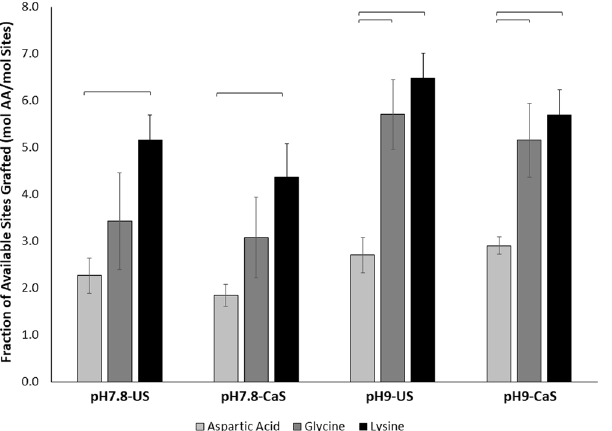
Figure 6. Molar ratio of total sites grafted on the ns-nHA surface using different amino acids (AA) following the fluoraldehyde protocol. Aspartic acid was again found to attach to fewer available graft sites on ns-nHA than the other two amino acids. Data reported as average ± one standard deviation (n = 5). ns-nHA unsaturated with calcium is given as US, while that pre-saturated with calcium is given as CaS. Horizontal bars indicate statistically detectable difference (p <